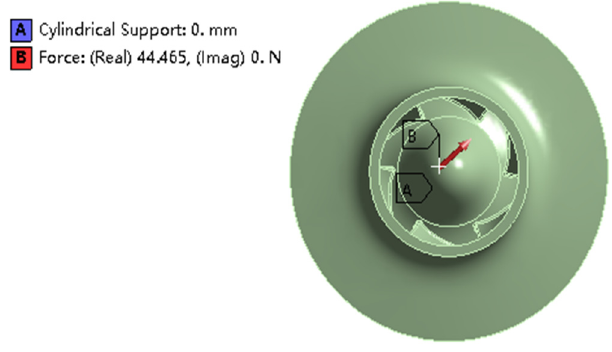
Figure 12. Impeller harmonic response analysis settings.